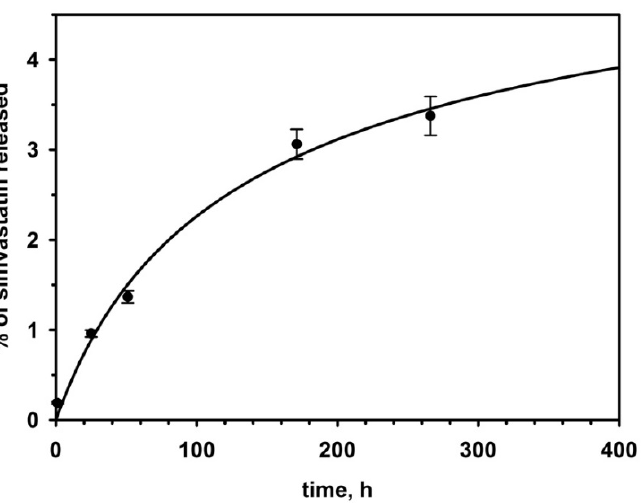
Figure 1. Dependence of the fraction of simvastatin released from SVPLA microspheres versus time.